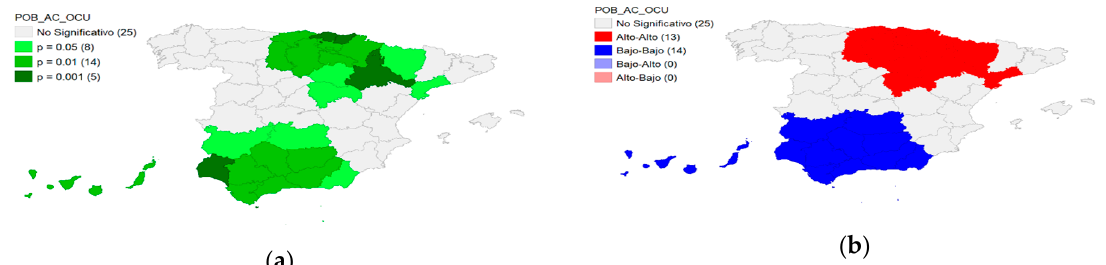
Figure 12. Significance map ( a ) and clusters map ( b ) for the variable employment level. Northern provinces show higher employment rates than southern ones, revealing behavior and dichotomy that is also observed in the rest of the variables studied. We correlated this variable with success and liquidation specialization through Moran’s Bivariant Index, and the results are depicted in Figure 13.